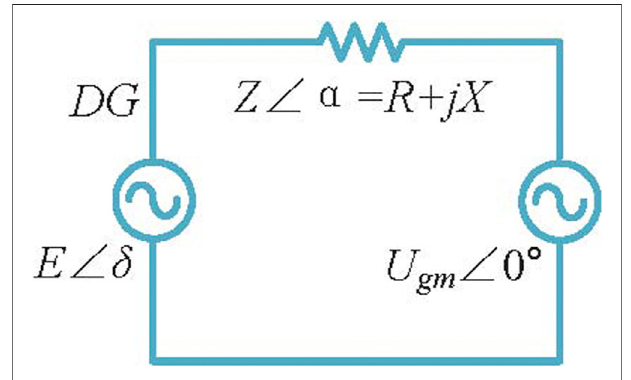
FIGURE 4 | The equivalent circuit when VSG operates in grid- connected mode.